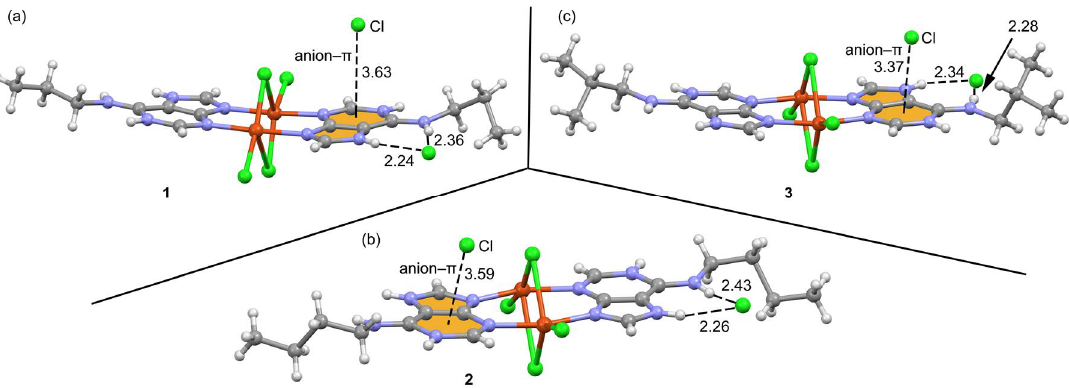
Figure 4. Detail of the anion–π interactions observed in compounds 1 ( a ), 2 ( b ) and 3 ( c ). Distances in Å.